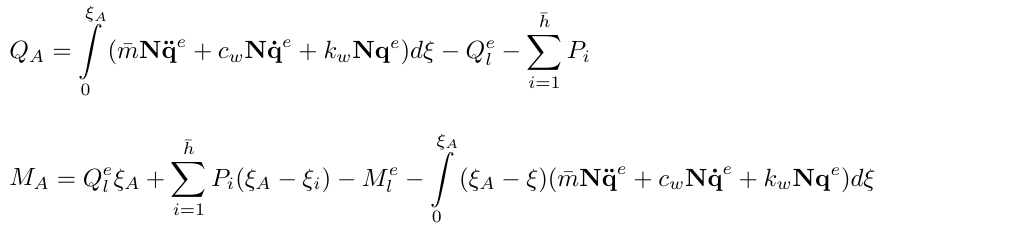
Fig. 4. Free-body diagram of portion of a typical beam element on viscoelastic foundation, in which f I ( ξ ) = ¯ m N¨q f D ( ξ ) = c w N˙q e